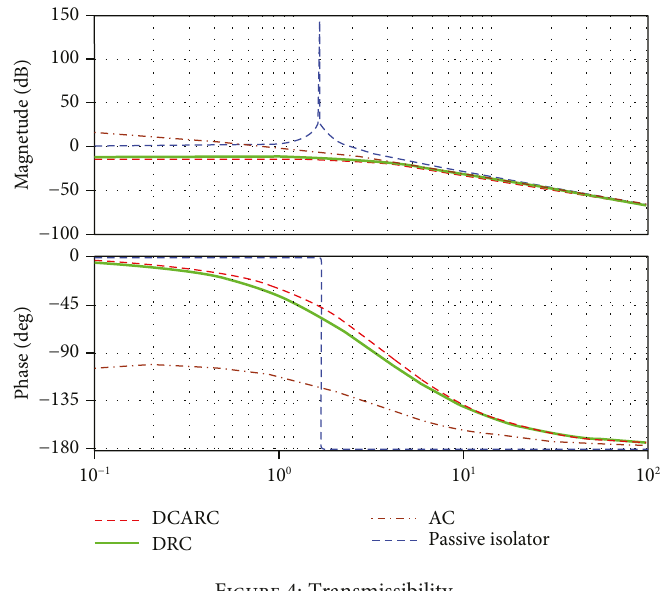
Figure 4: Transmissibility.